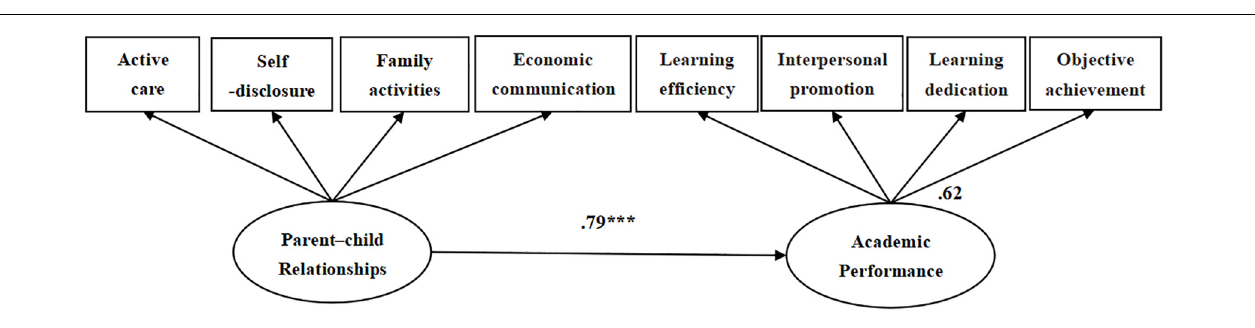
( Table 7 ), supporting the partially chain-mediating effect hypothesis